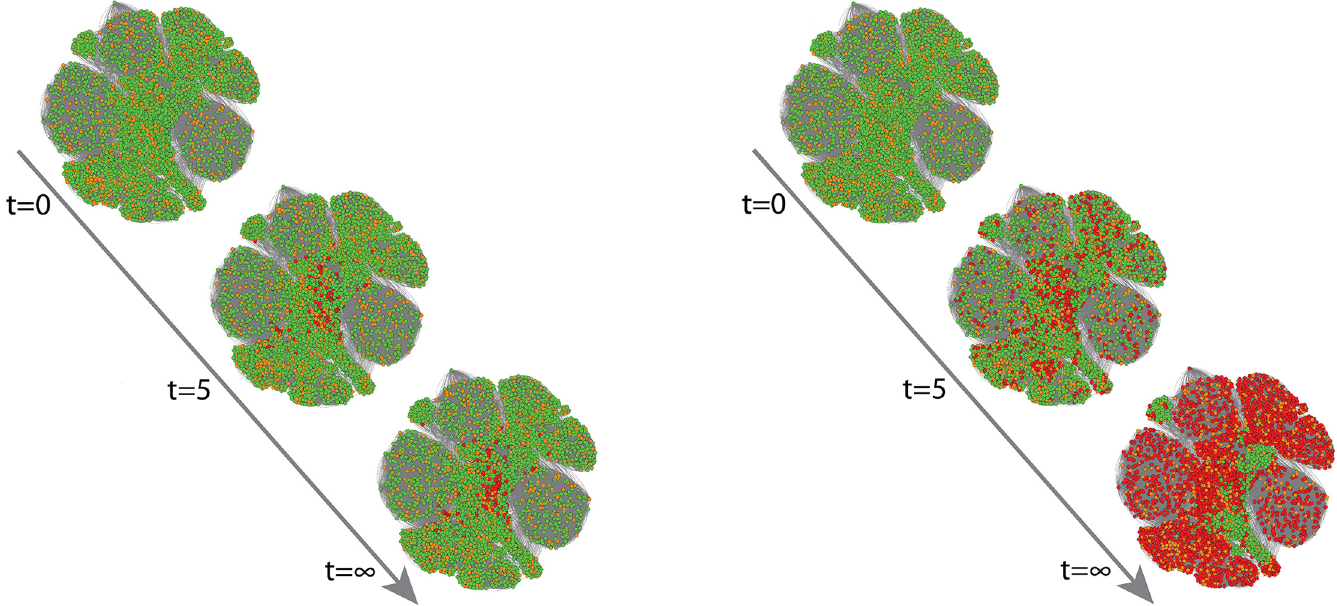
Fig 2. Visualization of the spread of opinion in the TM model on a facebook network with z = 43 and N = 4039. The fraction of the randomly selected initiators is p = 0.20. The mean threshold is ϕ 0 = 0.50 while the standard deviation of the threshold is (a) σ = 0, (b) σ = 0.20. Inactive nodes, initiators, and active nodes (through spreading) are marked with green, orange, and red,